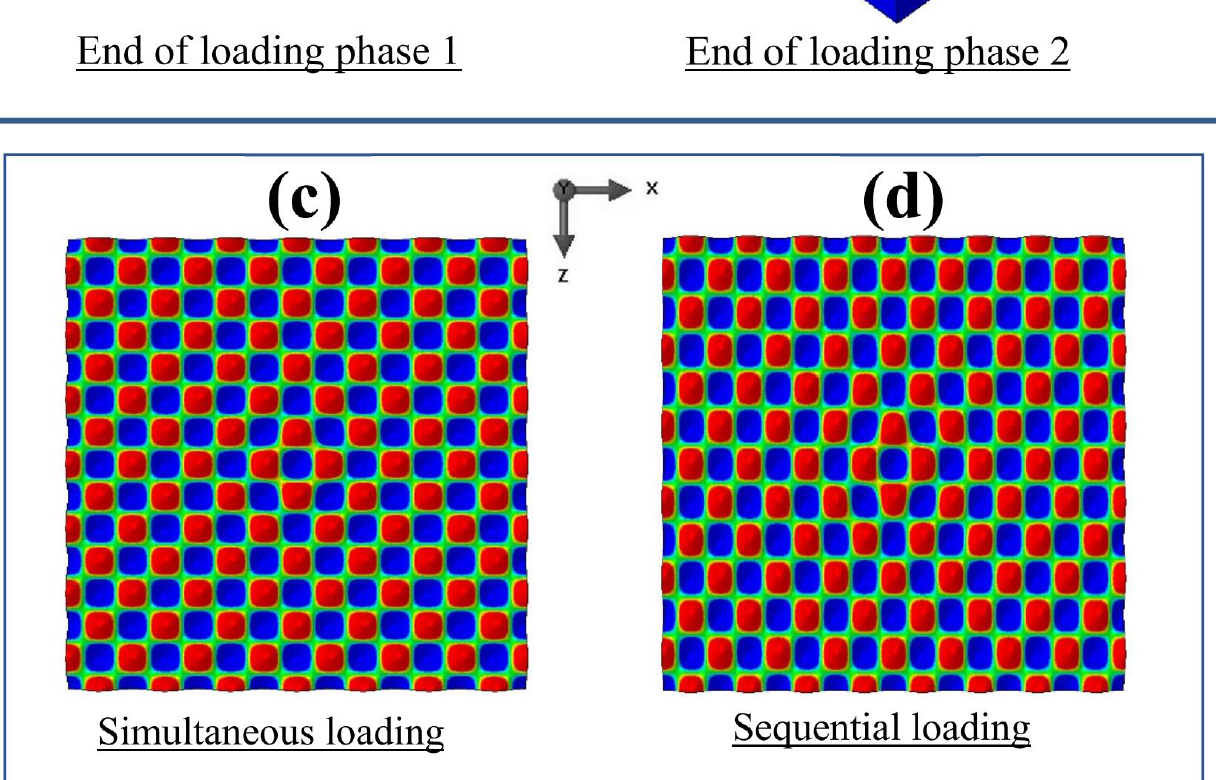
Figure 4. ( a , b ): Snapshots of simulated surface patterns during a sequential loading at ( a ) the end of phase 1 and ( b ) at the end of phase 2. ( c ) Square checkerboard wrinkling pattern obtained from a simultaneous loading. ( d ) Non-square checkerboard wrinkling pattern obtained from a sequential loading.